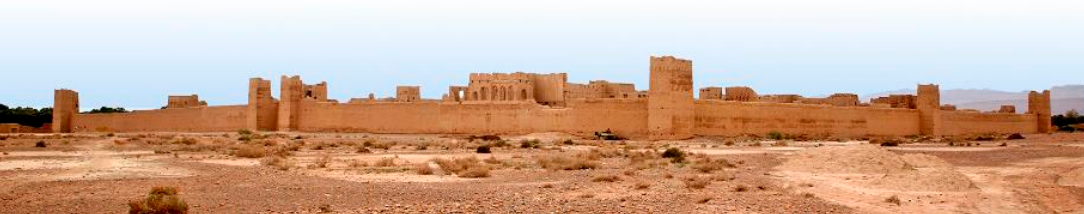
Figure 1. Sidi Bou Abdellah Ksar. Mdagra Oasis.